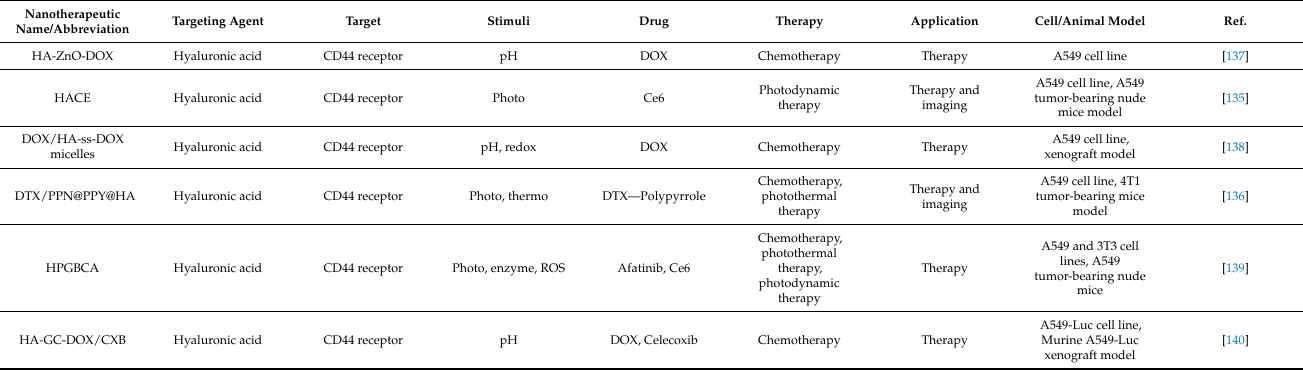
Table 3. Recent smart nanotherapeutics for lung cancer that are simultaneously targeted and